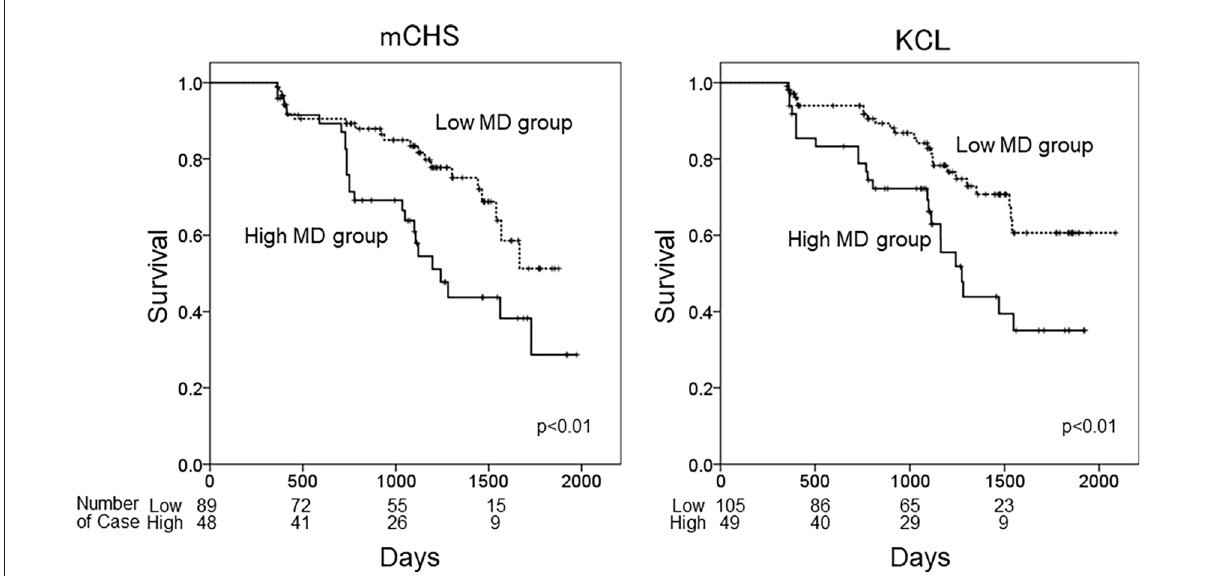
FIGURE1 Kaplan–Meier curves of frailty-free survival. The patients were categorized into two groups based on frailty defined using the mCHS or KCL and based on the cutoff MD values of the left ATR. High MD group: MD ≥ 7.8 × 10 − 4 , low MD group: MD < 7.8 × 10 − 4 . mCHS, modified Cardiovascular Health Study criteria; KCL, Kihon Checklist; lATR, left anterior thalamic radiation; MD, mean diffusivity; rATR, right anterior thalamic